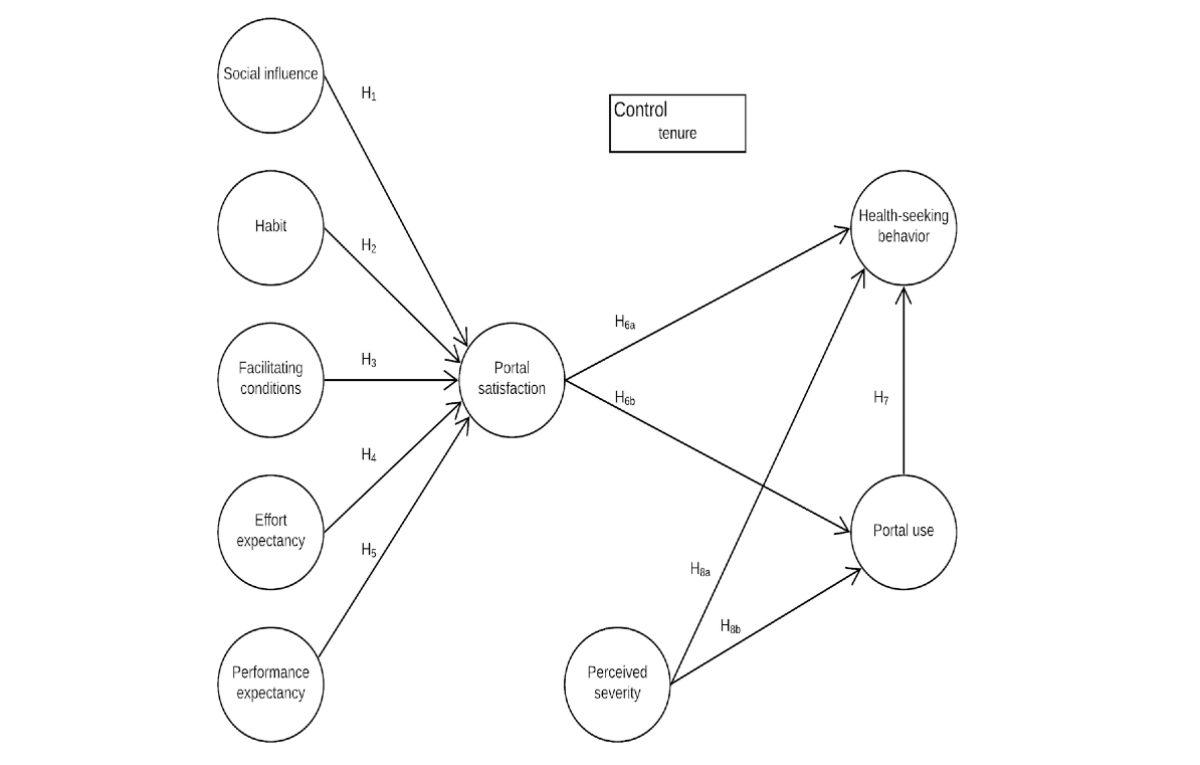
Figure 1. Proposed research